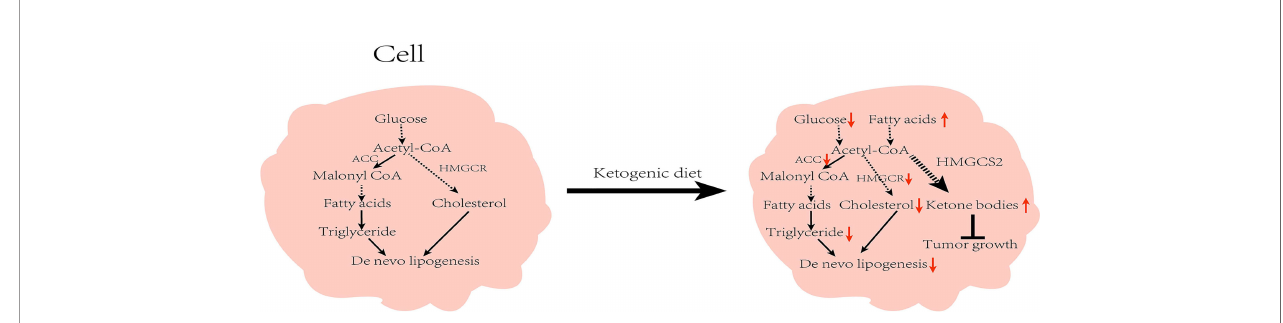
FIGURE 3 | Effect of ketogenic diet on lipid metabolism in cells: While on the ketogenic diet, carbohydrates intake is reduced and the activity of acetyl-CoA carboxylase and b -hydroxy- b -methylglutaryl-CoA reductase are inhibited, which in turn reduces de novo lipid synthesis. Concurrently, increased fat mobilization and ketone body production inhibit tumor growth. ACC, Acetyl-CoA carboxylase; HMGCR, b -hydroxy- b -methylglutaryl-CoA reductase; HMGCS2;